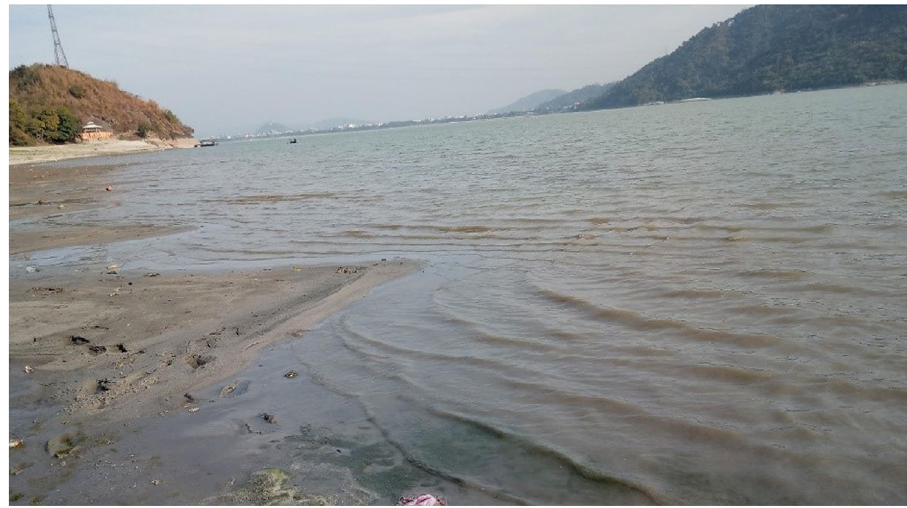
Figure 1. Soil collection site at Brahmaputra riverbank.